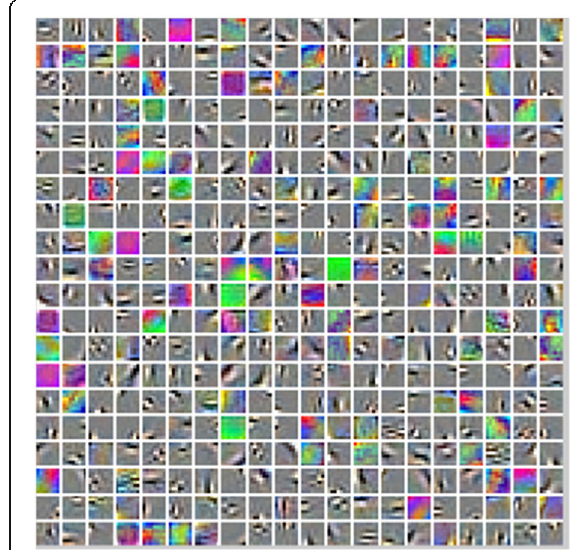
Fig. 4 The visualizing display of the higher layer local eigenvector extracted by the SAE model